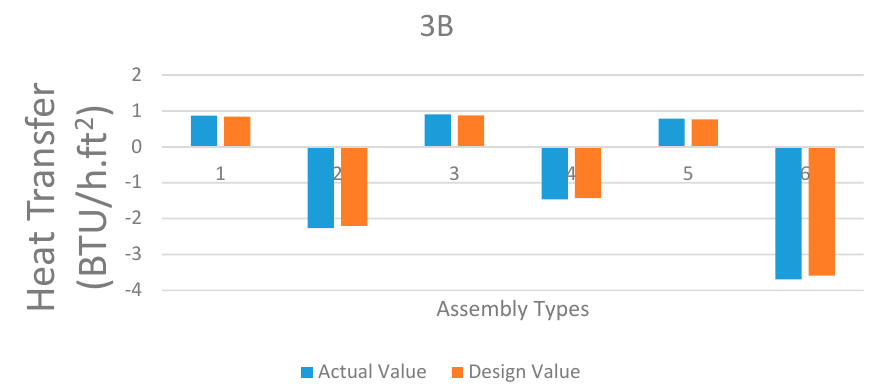
Figure 9. Heat losses in Assembly 3B (with series 1–6 representing the weather conditions as given in Table 8).